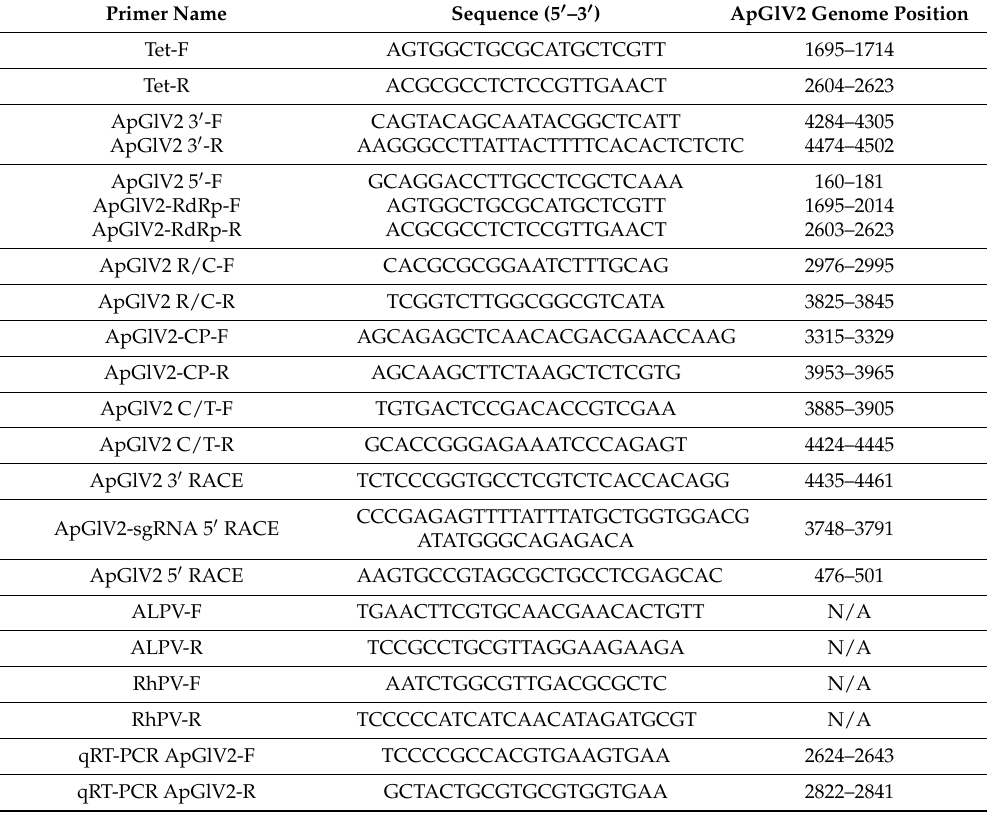
Table 1. Primers used for reverse transcription PCR (RT-PCR) and rapid amplification of cDNA ends (RACE) PCR for ApGlV2, ALPV, and RhPV in A. glycines and for PCR to test for the presence of ApGlV2 sequences in the aphid genome. F denotes a forward primer while R denotes a reverse primer. N/A, not